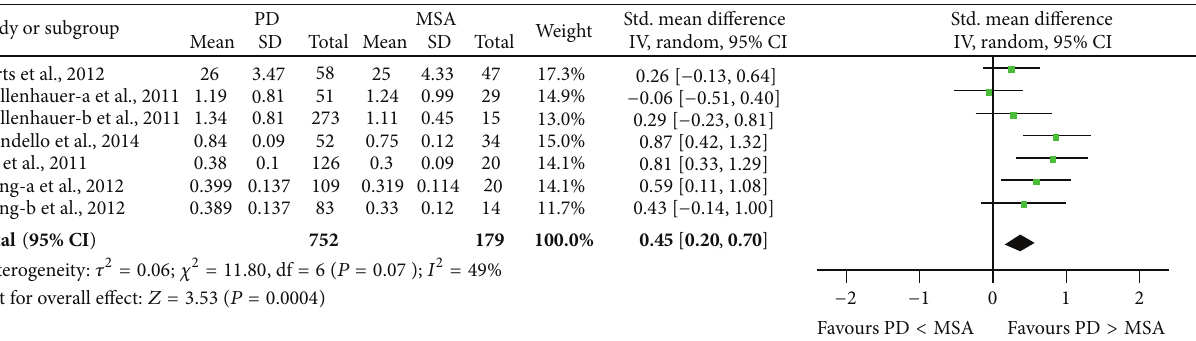
Std. mean difference